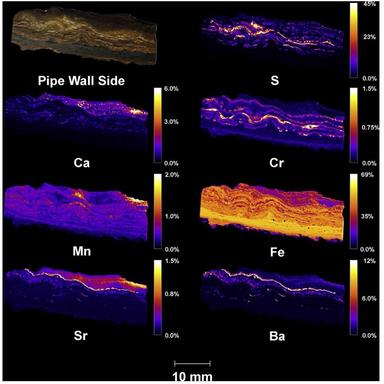
Micro-XRF mapping of sample 6.